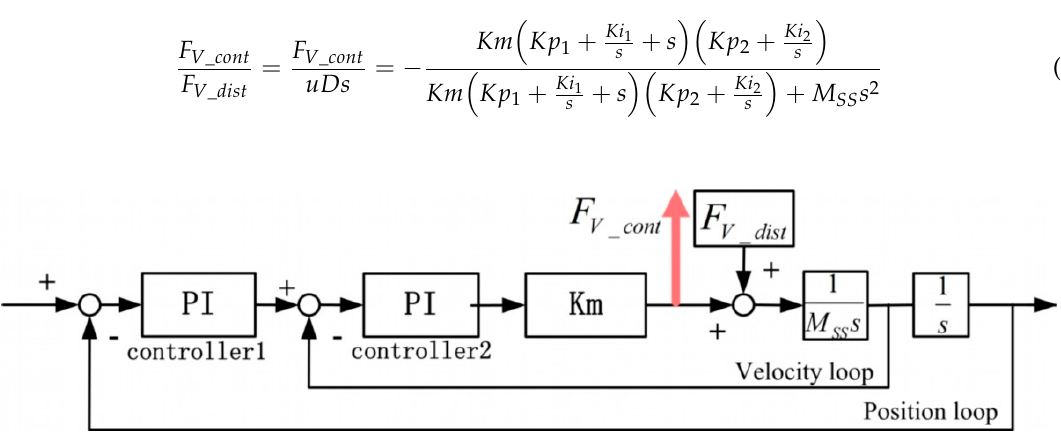
Figure 9. SS controller structure with the velocity-dependent disturbance forces (VDDFs) as input and controller forces as output.